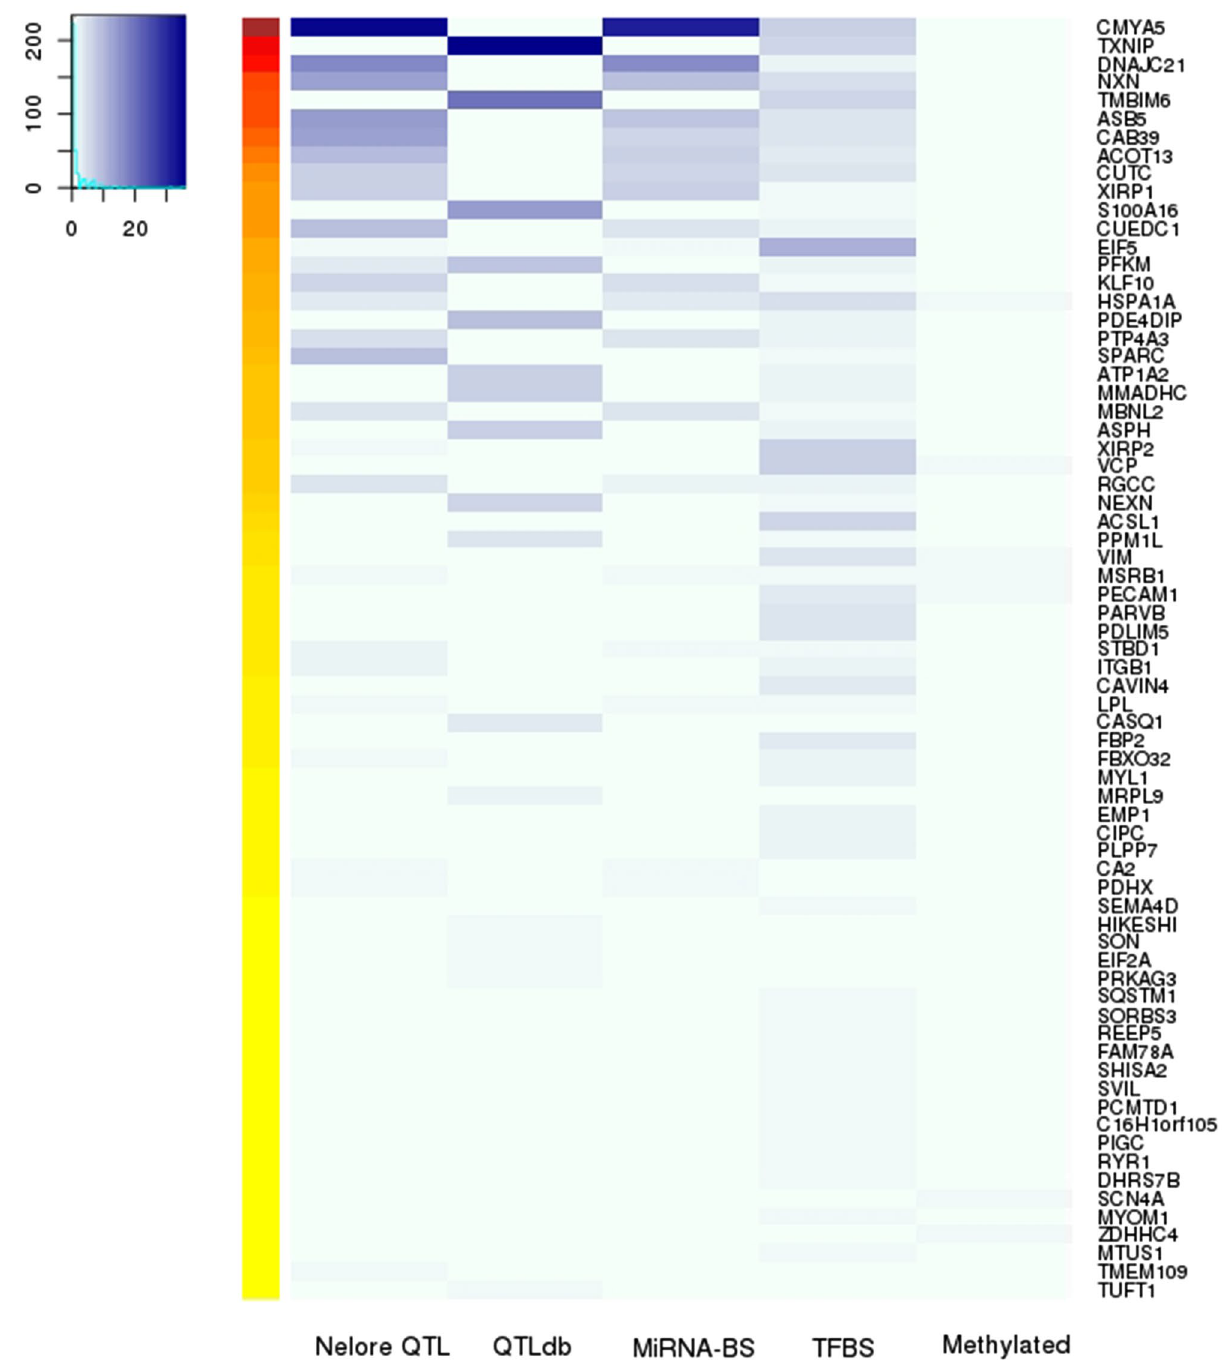
Figure 5. Heatmap of the aseQTLs distribution according to the associated gene and the regulatory regions predicted here. In the rows are the ASE genes for which we found at least one aseQTL inside a regulatory region. Columns represent “results sections”: Nelore QTLs have the number of aseQTLs that overlapped with Nelore GWAS data; QTLdb has the aseQTLs in QTLs regions from Cattle QTL Database; miRNA-BS, TFBS, and methylated columns have the aseQTLs that potentially changes miRNA binding sites, transcription factors binding sites and that was methylated. The blue scale increases according to the presence of aseQTLs in each results section. The left heatmap with hot colors represents the total of regulatory regions that combine with our aseQTL data for each gene. The figure was created with Gplots R package (https:// github. com/ talga lili/